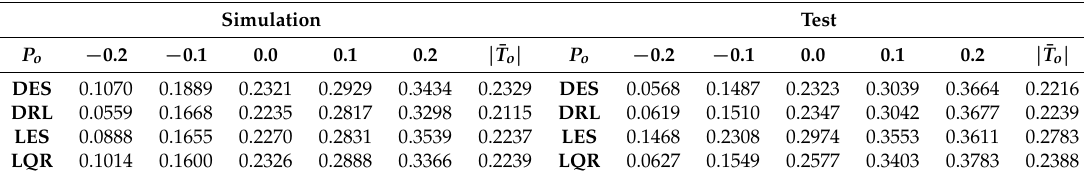
Table 5. Minor loop gain for the microgrid buck-buck.